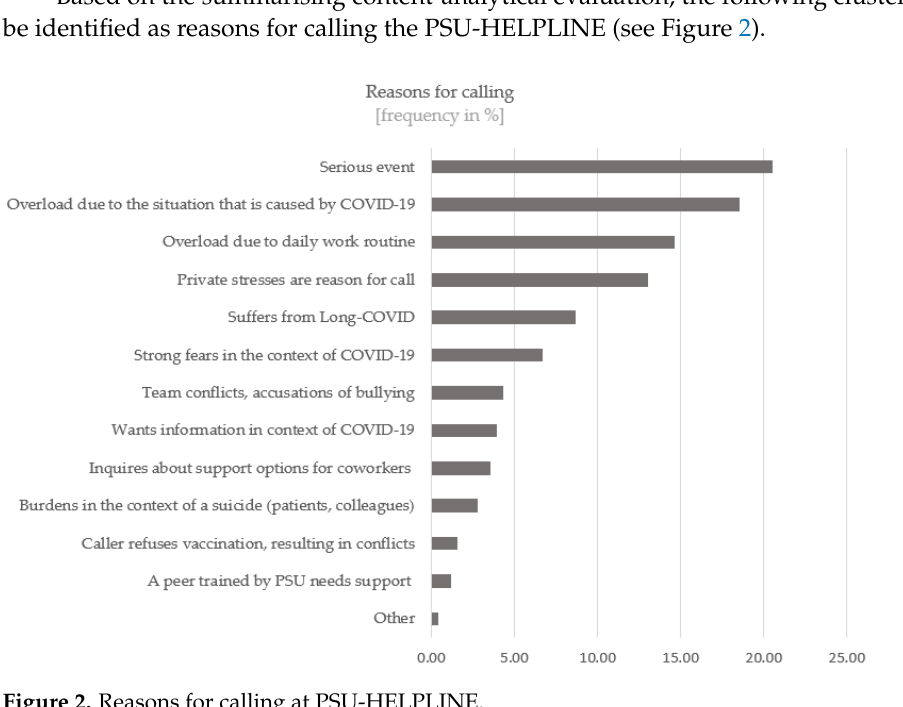
Table 2. Identified effect factors and their